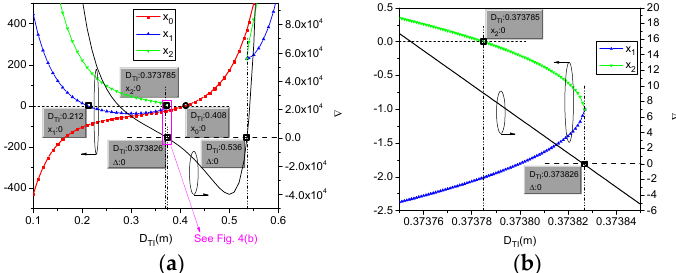
I ) when D TR = 0.7 m: RX